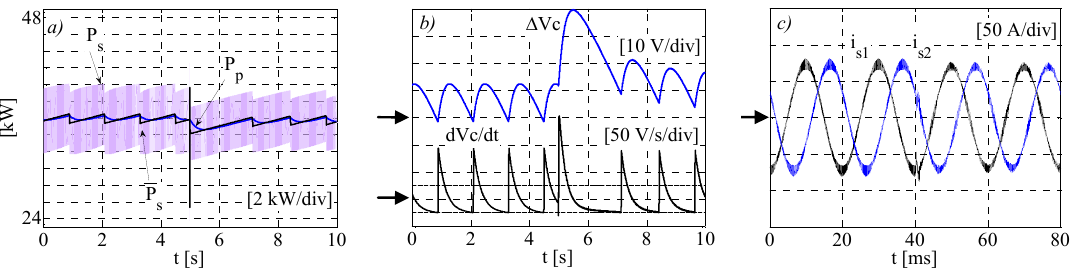
Figure 9. Main electrical quantities during steady state condition at 250 W/m 2 radiation value around the fault instant: ( a ) grid and PV Powers; ( b ) capacitor voltage and time derivative; ( c ) line currents.